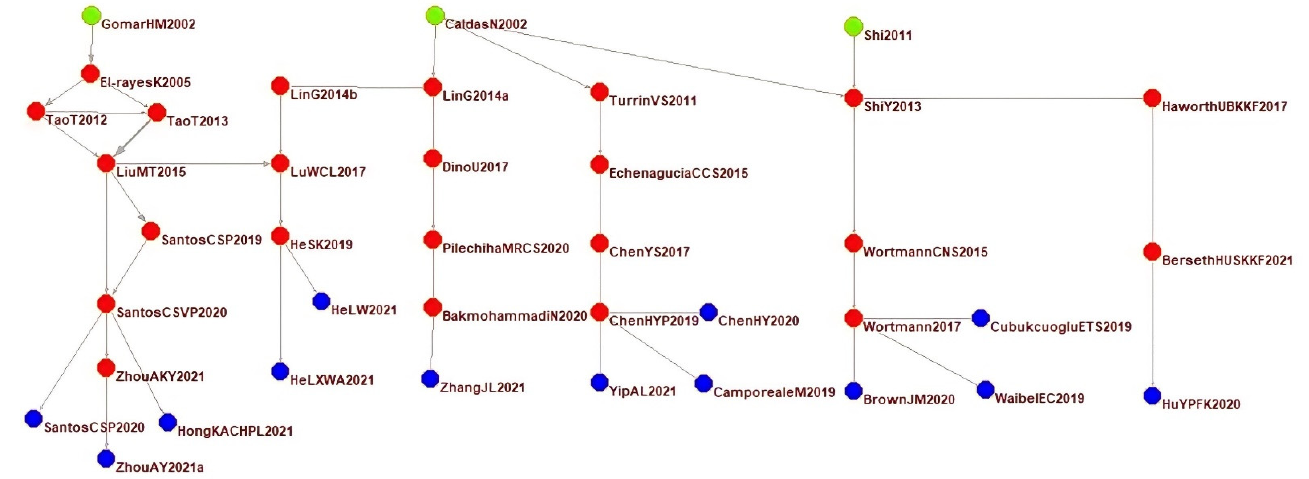
Figure 6. Main Paths B.